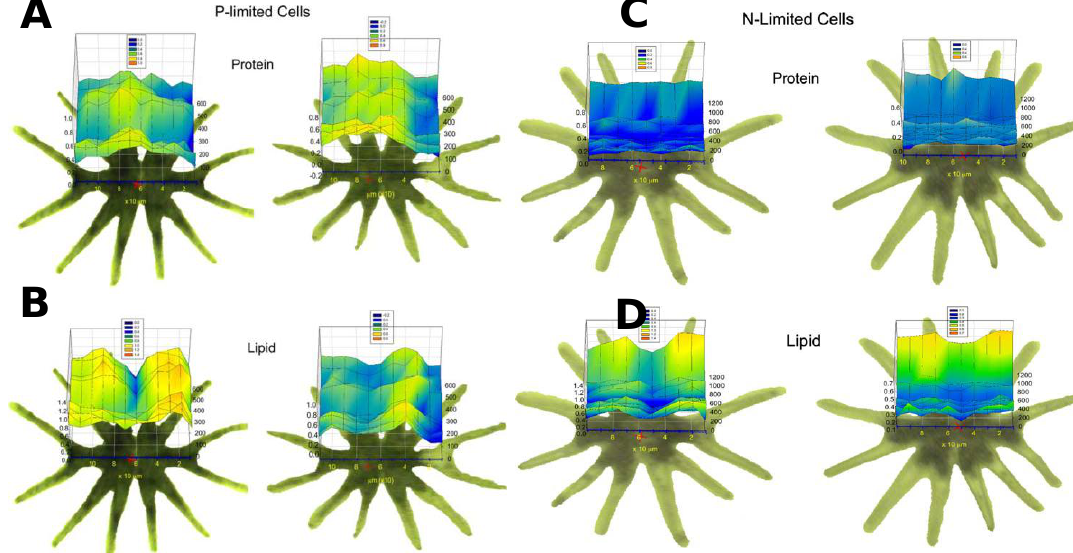
Figure 5. Spatial and temporal changes of lipid and protein concentrations in living M. hardyi algal cells subjected to P-starvation ( A , B ) and N-starvation ( C , D ) following nutrient resupplying. The x -axis represents position along the cell and the y -axis represents time following resupply of P ( A , B ) or N ( C , D ). (Reprinted with permission from [9]. Copyright 2006 John Wiley and